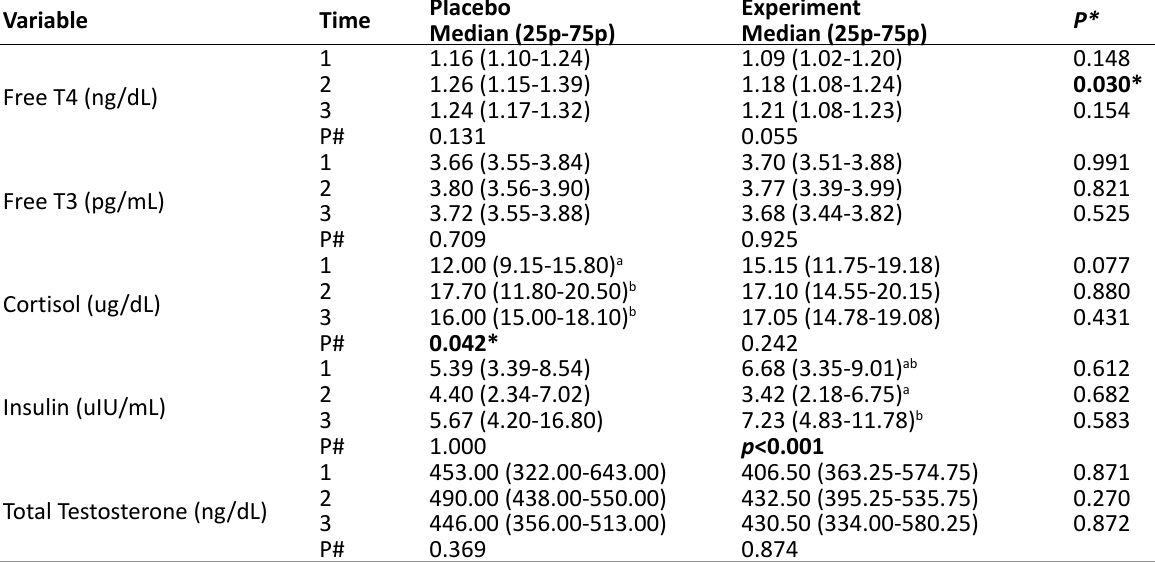
Table 3. Comparison of hormonal changes of the